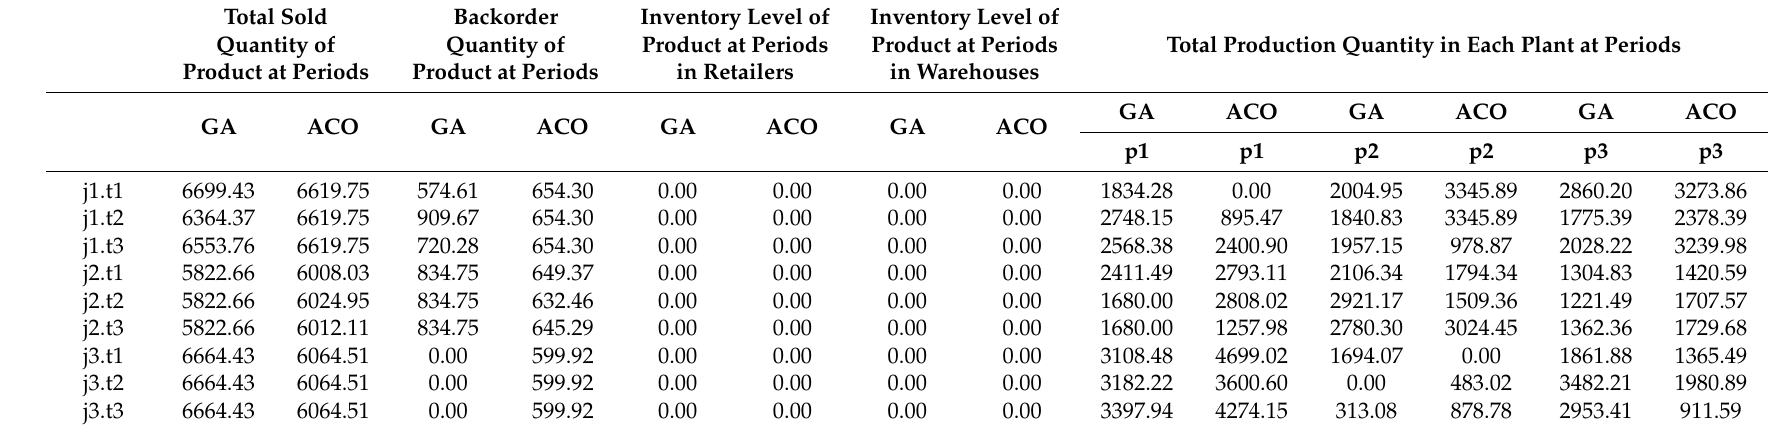
Table 5. Summary of